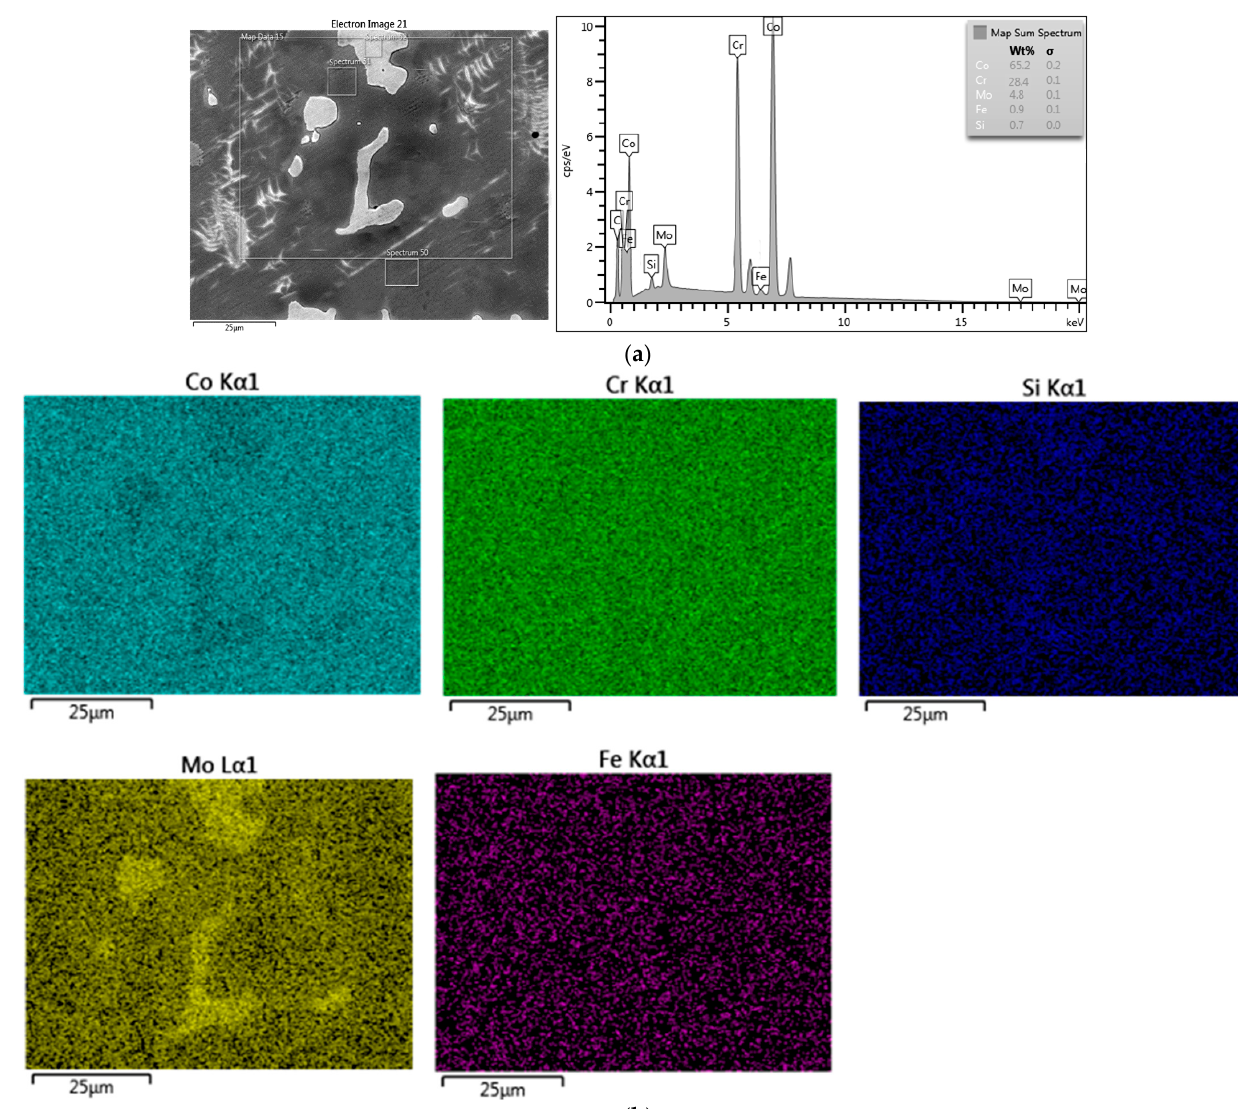
Figure 2. SEM–EDS results for MC-Control: ( a ) SEM-SE micrograph showing morphology with averaging EDS results from the marked area; ( b ) the surface distribution of Co, Cr, Si, Mo, Fe from the marked area.